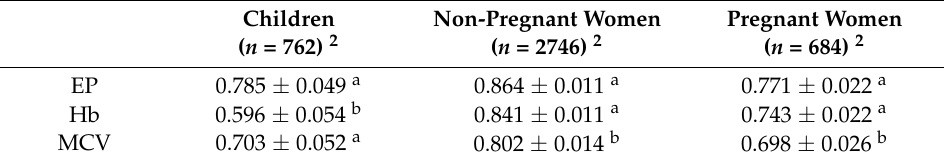
Table 3. Comparison of the areas under the receiver operating characteristic (ROC) curves (Mean ± SE) of erythrocyte protoporphyrin (EP), hemoglobin (Hb), and mean cell volume (MCV) in detecting iron deficiency in children (three to five years p;d), non-pregnant women (15–49 years), and pregnant women from the National Health and Nutrition Examination Surveys (NHANES, 2003–2006 for children and non-pregnant women, 1999–2006 for pregnant women), after excluding subjects who had signs of infection, as indicated by abnormal white blood cell counts (>10.0 × 10 9 /L) or elevated C-reactive protein (>5 mg/L) or of possible liver disease, as defined by at least one of two abnormal elevations (more than two times the upper limit of normal value) on alanine aminotransferase (>70 U/L) and aspartate aminotransferase (>70 U/L) 1 . Children Non-Pregnant Women Pregnant Women ( n = 762) 2 ( n = 2746) 2 ( n = 684) 2 EP 0.785 ± 0.049 a 0.864 ± 0.011 a 0.771 ± 0.022 a Hb 0.596 ± 0.054 b 0.841 ± 0.011 a 0.743 ± 0.022 a MCV 0.703 ± 0.052 a 0.802 ± 0.014 b 0.698 ± 0.026 b 1 EP, erythrocyte protoporphyrin; Hb, hemoglobin; MCV, mean cell volume. To generate the ROC curves, EP was converted to the preferred unit of µ mol EP/mol heme by multiplying by 50. 2 Values with different